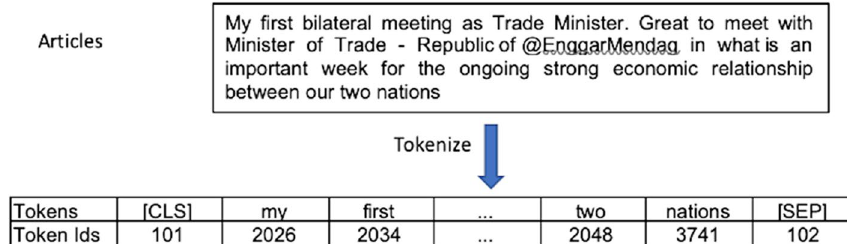
Fig. 1 An example of the tokenisation process